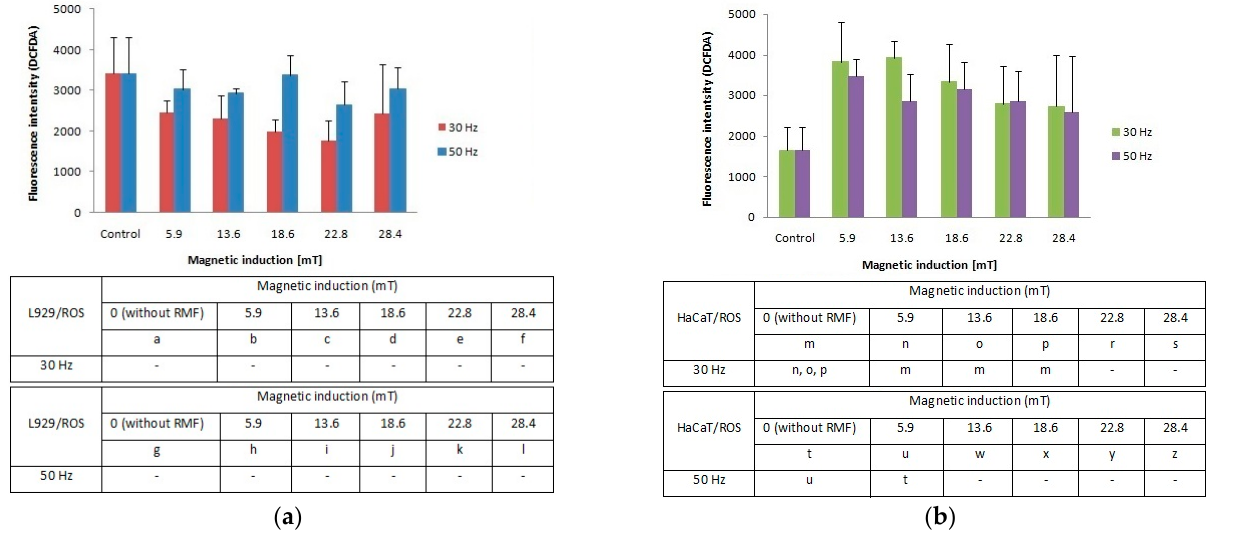
( b ) Figure 2. Relative viability after 4-hour exposition to different magnetic induction and frequency of RMF. ( a ) NRU assay results for L929 cell line; ( b ) NRU assay results for HaCaT cell line lines (all samples were compared to control; p -values ˂ 0.05 were considered significant and were represented by small letters). 2.2. Reactive Oxygen Species (ROS) Generated by RMF Our study demonstrates that the cellular response in the reactive oxygen species (ROS) level was different between L929 and HaCaT cell cultures. The L929 fibroblasts responded to the applied rotating magnetic field ( f = 30 Hz; B from 5.9 to 28.4 mT) with lower ROS accumulation in comparison to control cultures. A frequency of 50 Hz evoked an increase of ROS levels with the highest results for magnetic induction ( B = 5.9, 18.6 and